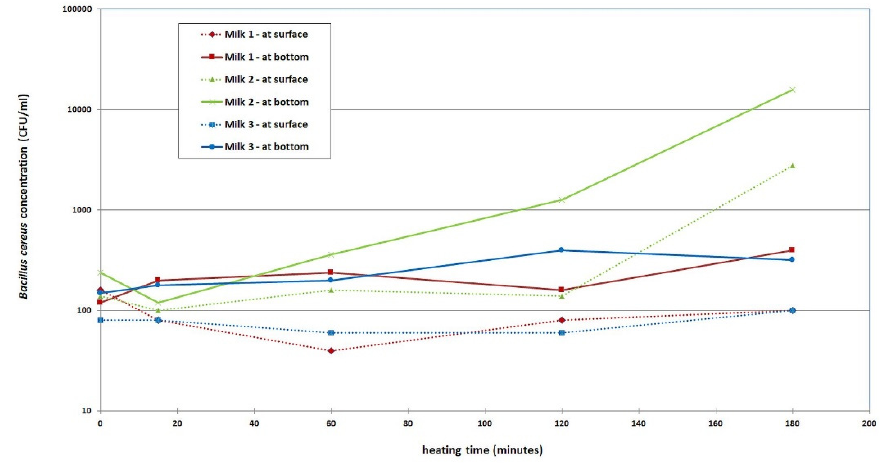
Figure 7. B. cereus growth during the warming of inoculated samples of thawed PBM. Table 2. Changes of B. cereus counts in thawed PBM during warming. Bottle Code Time of Warming